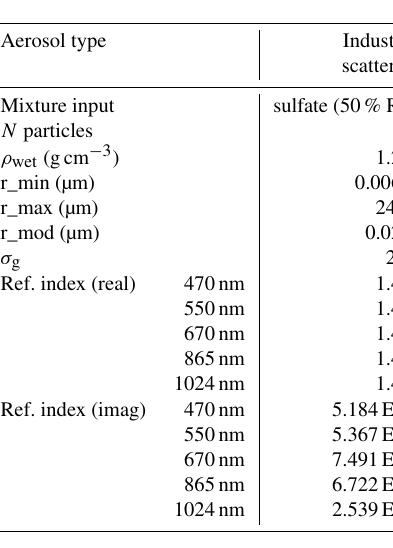
Table 1. Aerosol physical and optical properties for the different aerosol types considered in the benchmark. σ g is the geometric standard deviation. The refractive indices are linearly interpolated from the OPAC database (Hess et al., 1998). Dust refractive indices are linearly interpolated from Woodward